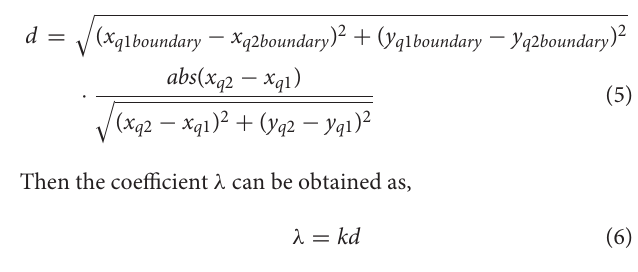
FIGURE 2 | Roadmap construction based on obstacle potential field.